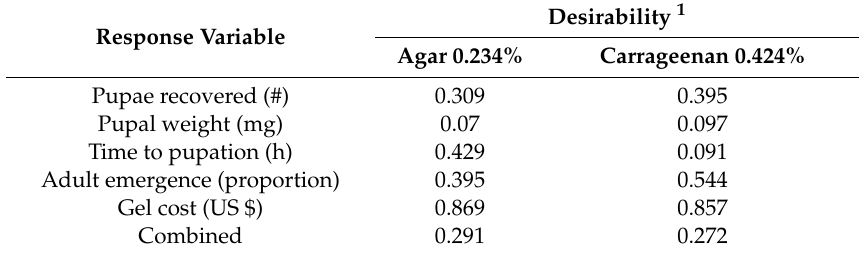
Table 3. Desirability values of the optimization analysis for the results of agar at 0.234% and carrageenan at